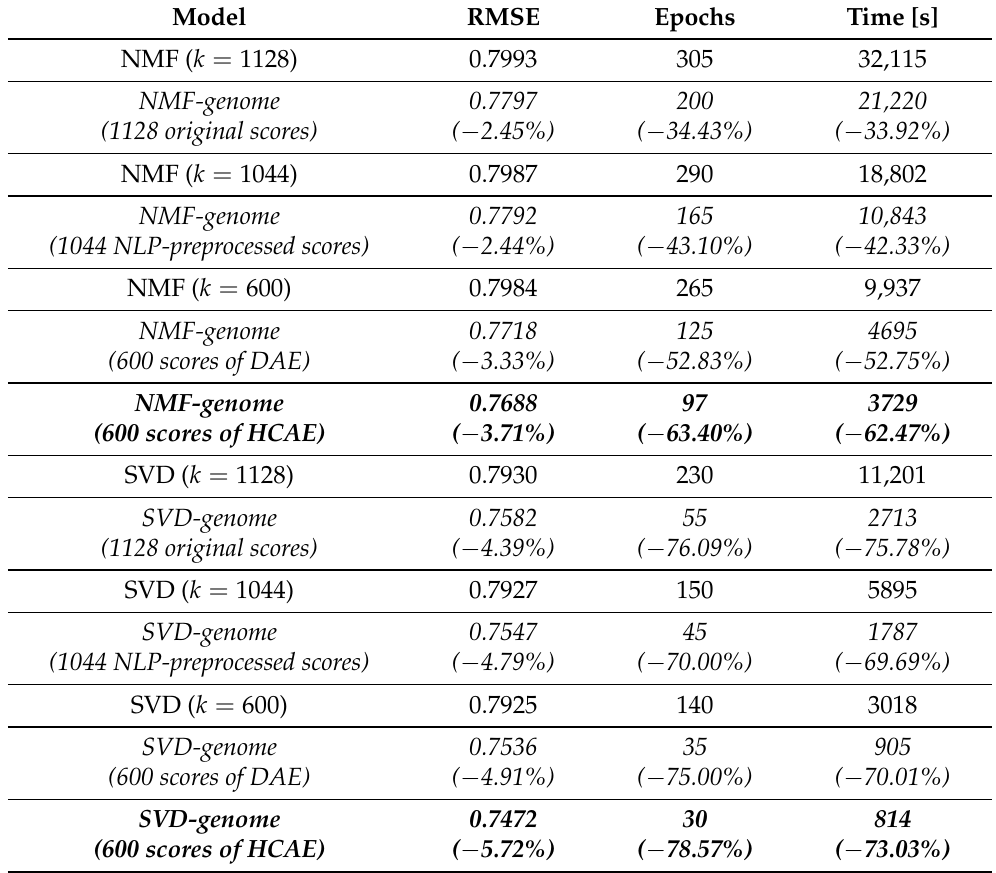
Table 5. Performance comparison between randomly initialized matrix factorization models and their custom initialized counterparts integrating user and movie feature